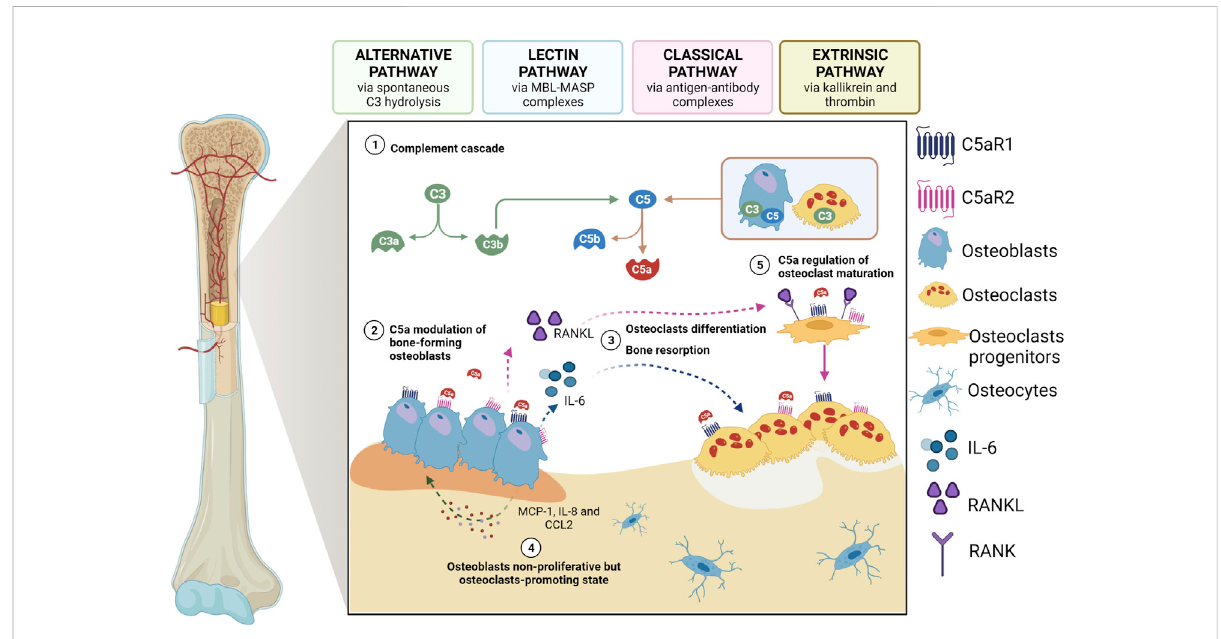
The role of C5a as a modulator of osteoblast-osteoclast interplay. 1) Activated complement system leads to the generation of C5a which can bind to C5aR1/2 on osteoblasts; 2) once activated by C5a, osteblasts start to release IL-6 and RANKL, thus inducing 3) osteoclastogenesis and bone resorption as well as differentiation of osteoclast progenitors; 4) activated osteoblasts can also secrete other chemokines and cytokines, such as MCP-1, CCL2 and IL-8, which in turn act on osteoblasts inducing a non-proliferative osteoclast-promoting state; 5) C5a also regulates the fi rst phase of osteoclastogenesis maturation. Created with